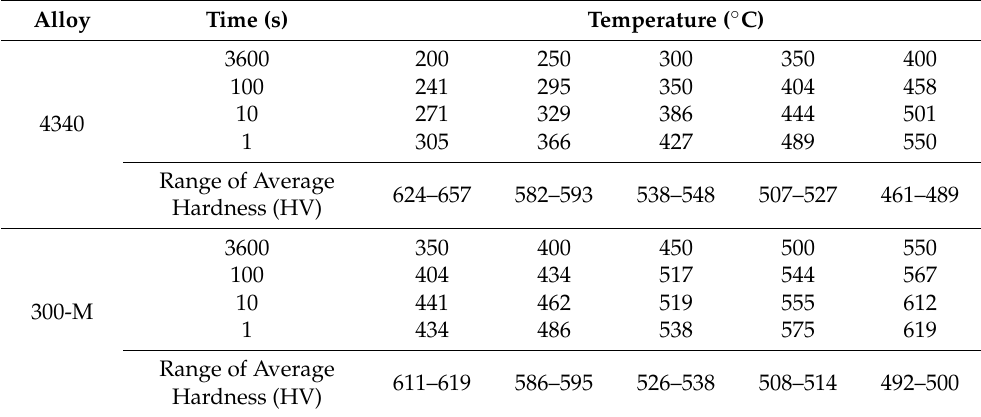
Table 2. 4340 and 300-M tempering matrices and associated tempered hardness